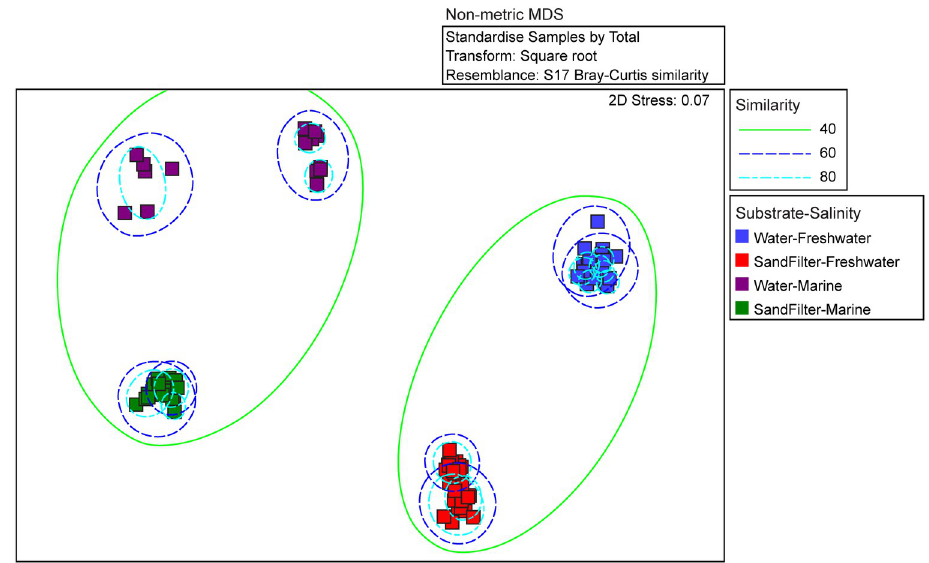
Fig 2. Non-metric multidimensional scaling (NMDS) analysis comparing microbial community composition from samples collected over the one-month sampling period. Samples are colored by substrate type and salinity. Each square represents a single timepoint. Ellipses represent percent similarity as calculated by the Bray-Curtis distance